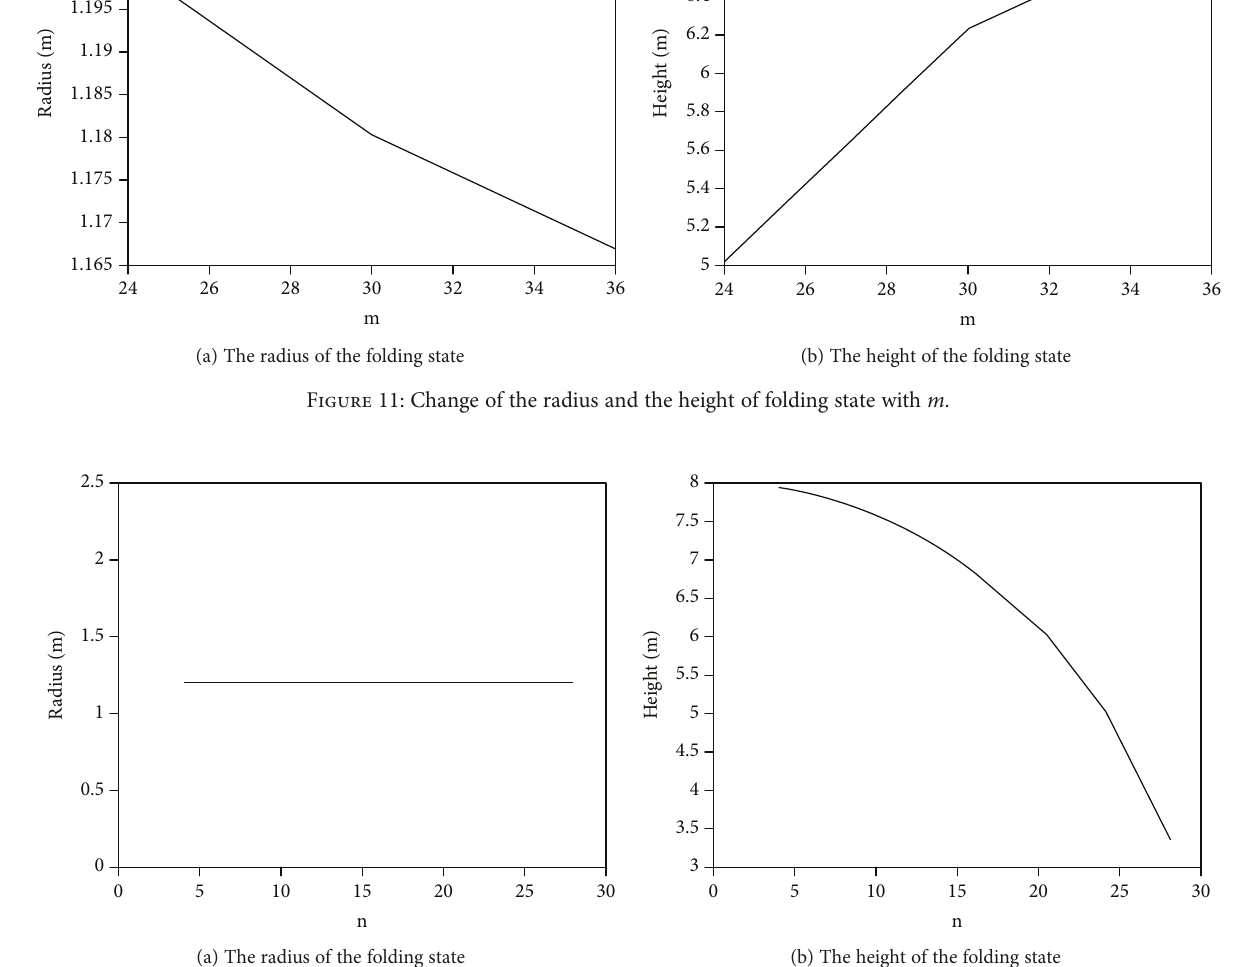
(b) The height of the folding state